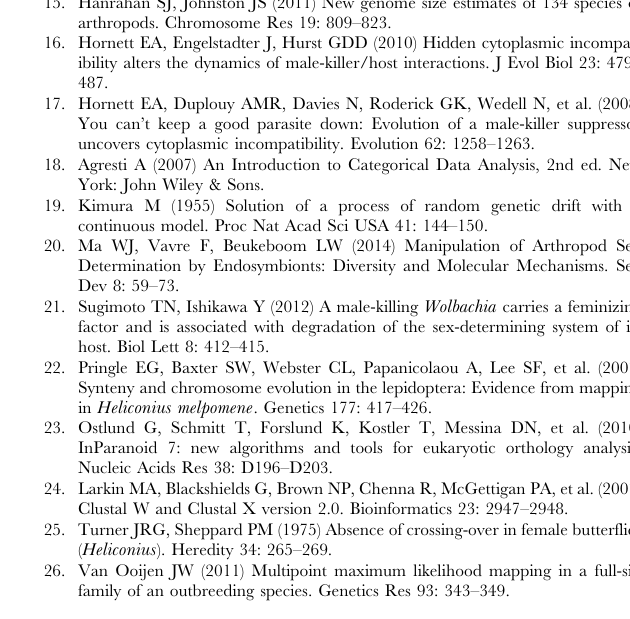
S2 Figure Results of statistical testing for genotypic differentiation between population samples at loci in the linkage group carrying the suppressor. Significance denoted by colour: deep red – significant differentiation as measured at p , 0.001; mid red – significant differentiation as measured at p , 0.01; pink – significant differentiation as measured at p , 0.05, all uncorrected for multiple tests. S3 Figure Allele frequency profiles of markers unlinked to the suppressor. Allele frequency changes for all 9 unlinked alleles (M-U) between 2001 (red) and 2006 (blue) at all 9 loci were not significant (Chi Square heterogeneity test; p . 0.05, Bonferroni corrected). S1 Table Marker loci information. Information of each of the 21 (12 suppressor-linked, and 9 unlinked) loci used in this study including gene annotation, linkage group and primers used. SLG: Suppressor Linkage Group; nt: nucleotides. (TIF) S2 Table Basic haplotype polymorphism information and accession numbers. S3 Table Polymorphism statistics and nucleotide diver- sity estimates for the 12 suppressor-linked loci (A-L) for the 2001, 2006 and 2010 Samoan population samples. # : number.